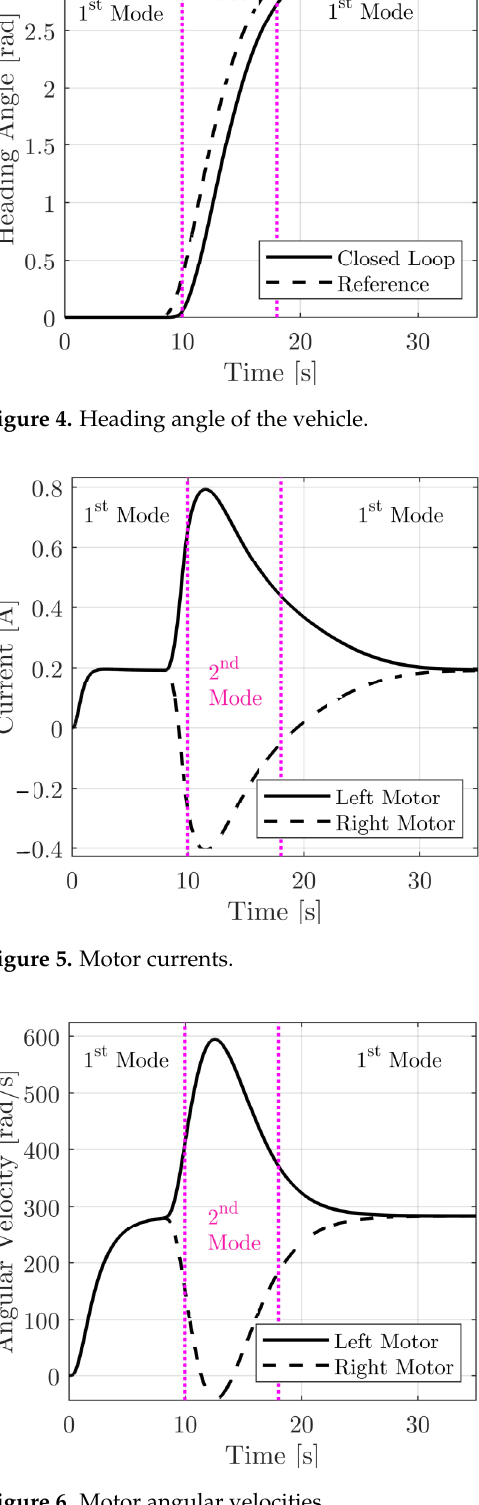
Figure 6. Motor angular velocities.